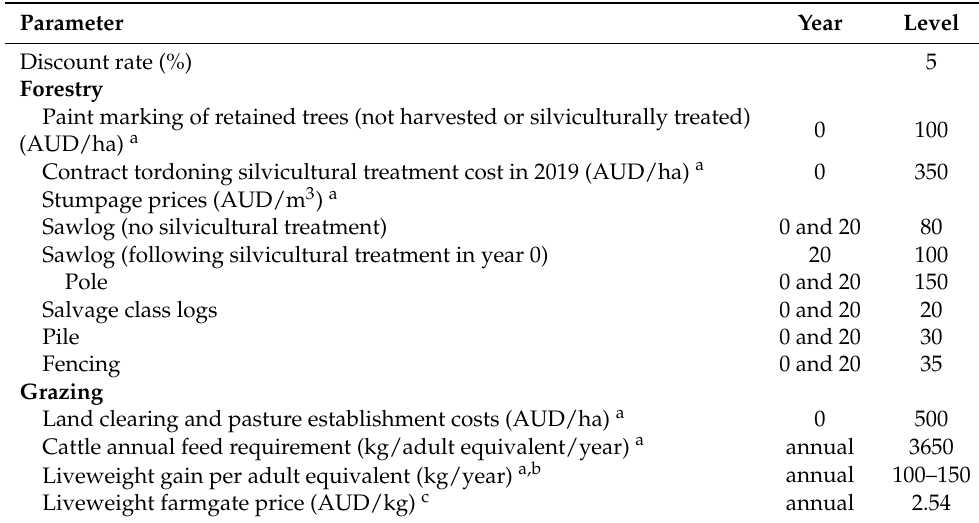
Figure 2. ( a ) Cleared land for grazing; ( b ) locked-up forest; ( c ) silviculturally treated forest; ( d ) high-graded forest. Note: Silviculturally treated and harvested forests look similar to silviculturally treated forests, with the difference being that commercial products are harvested during treatment. Table 2. Parameter levels adopted for the financial analysis of forest management